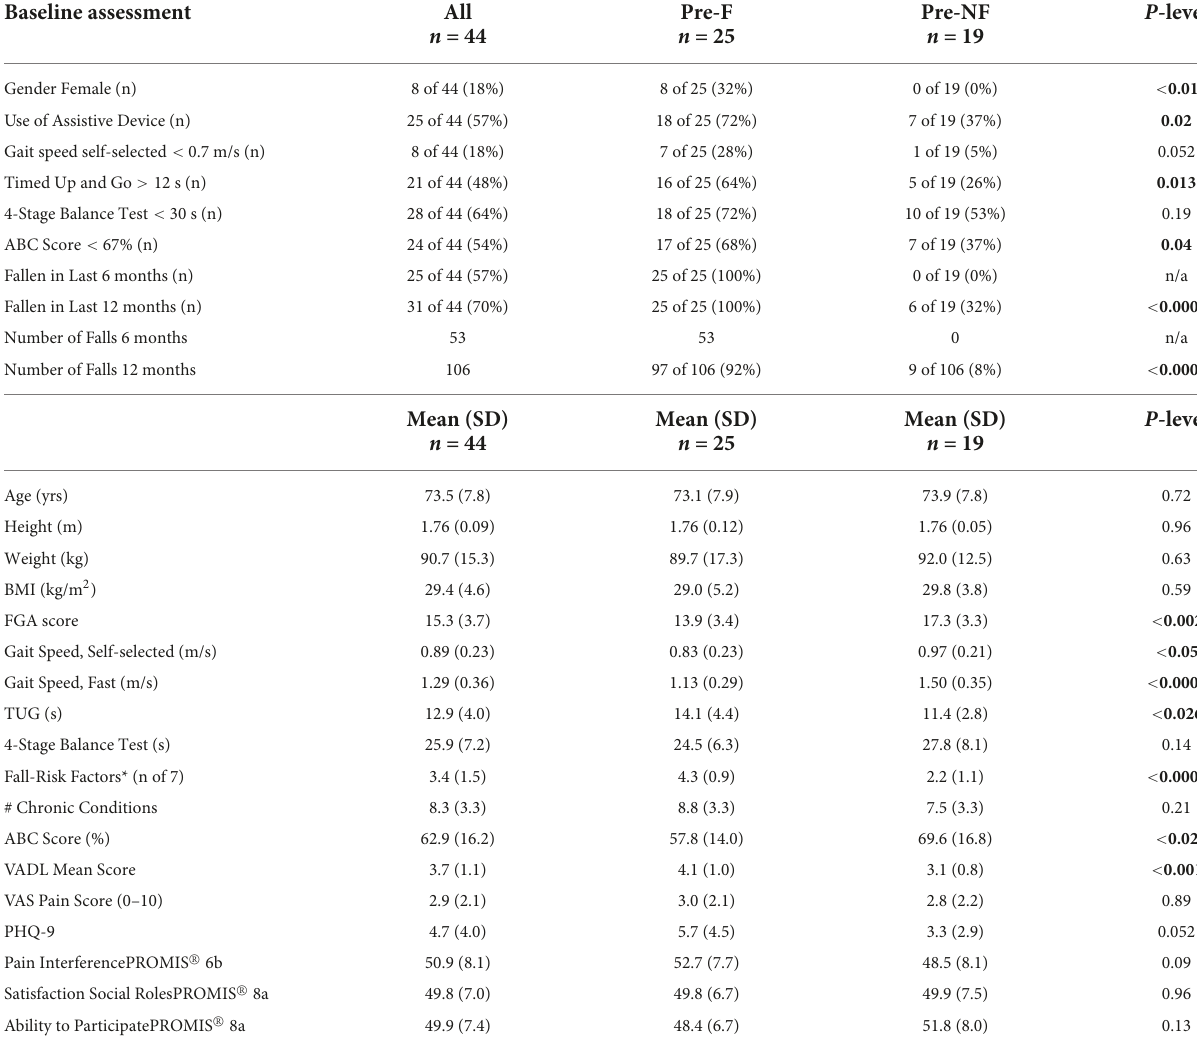
TABLE 2 Baseline characteristics for participants reaching the 26-week assessment ( n = 44).